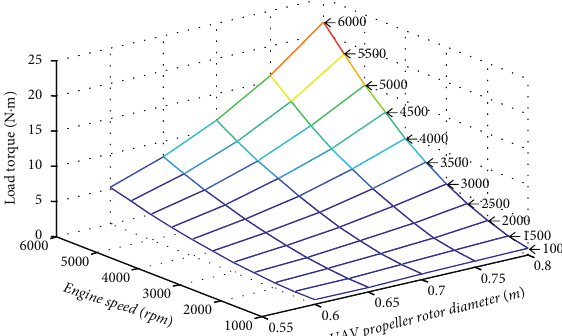
Control signal Current signal Needle valve Figure 7: Schematic diagram of needle valve displacement compensation.